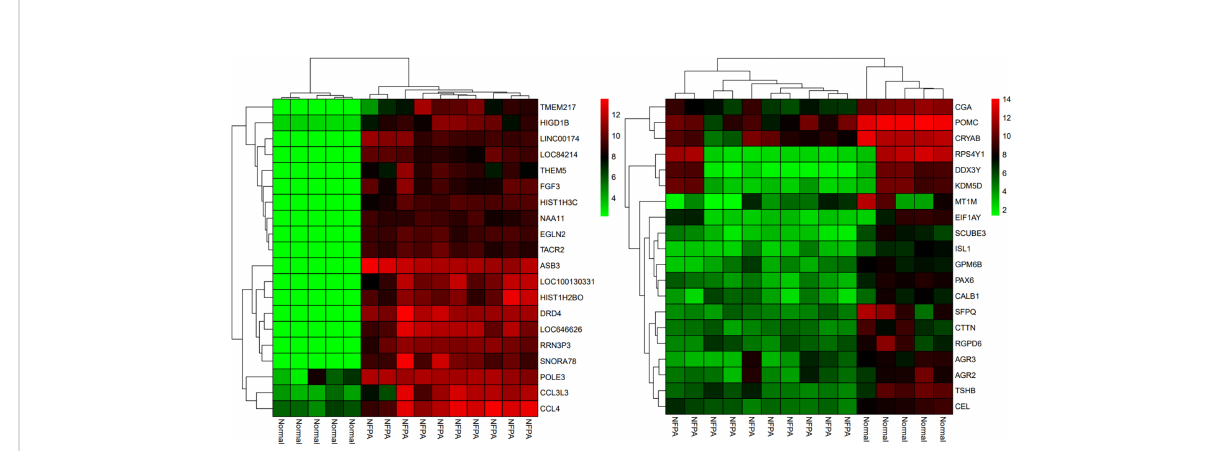
FIGURE 5 The two-way clustering of top 20 DEGs between NFPA samples and normal tissue samples; horizontal axis, the samples; vertical axis, DEGs between Normal tissues samples and NFPA